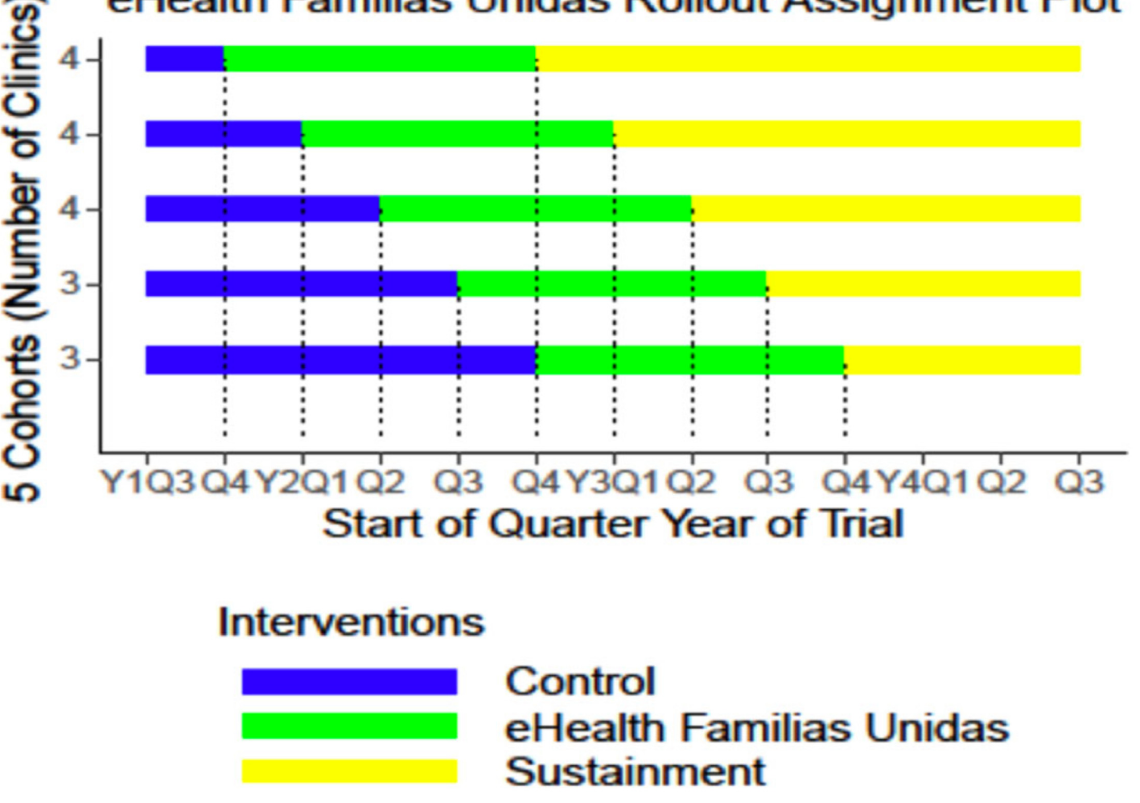
Fig 2. eHealth Familias Unidas rollout assignment